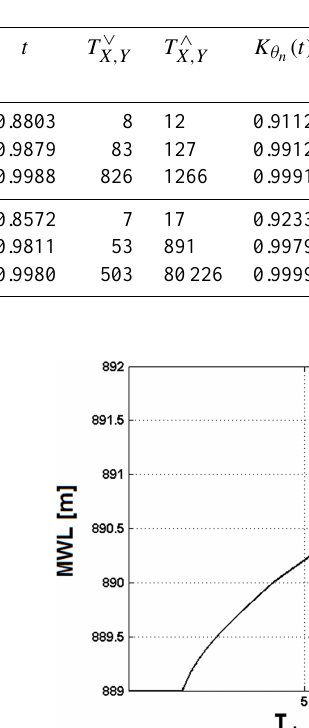
Table 6. Comparison between joint return periods associated to the theoretical events with peaks equal to q T and volumes equal to v T for T =10, 100 and 1000yr.